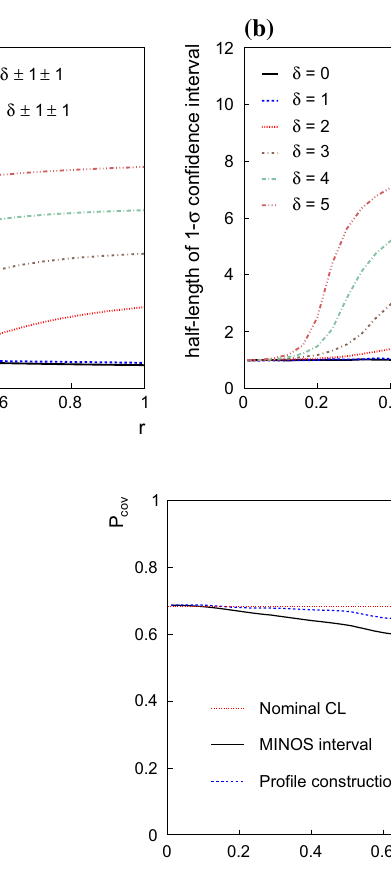
profile construction respectively; at r = 1, the correspond- ing values are 0 . 564 and 0 . 617 (the Monte Carlo statistical errors for all values is around 0.005). Thus reasonable agree- ment is found with both methods but one should be aware that the coverage probability may depart from the nominal value for large values of r